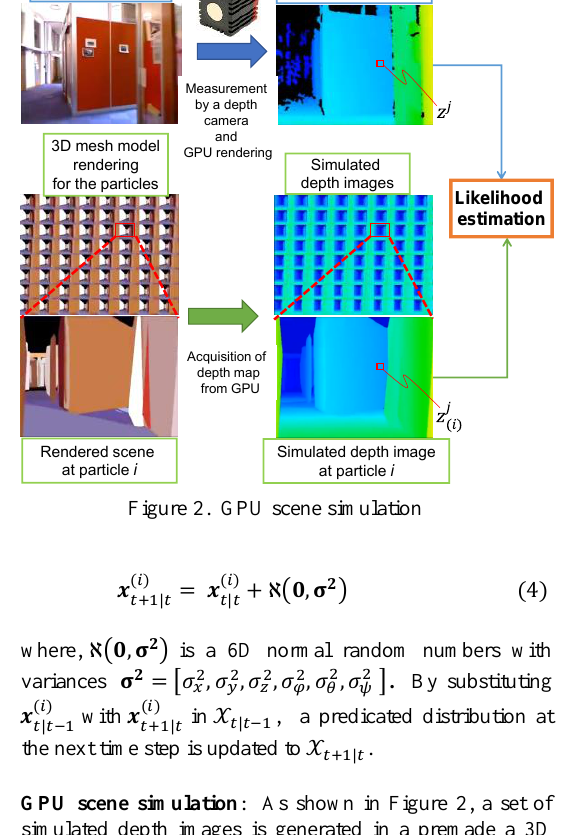
Figure 2. GPU scene simulation